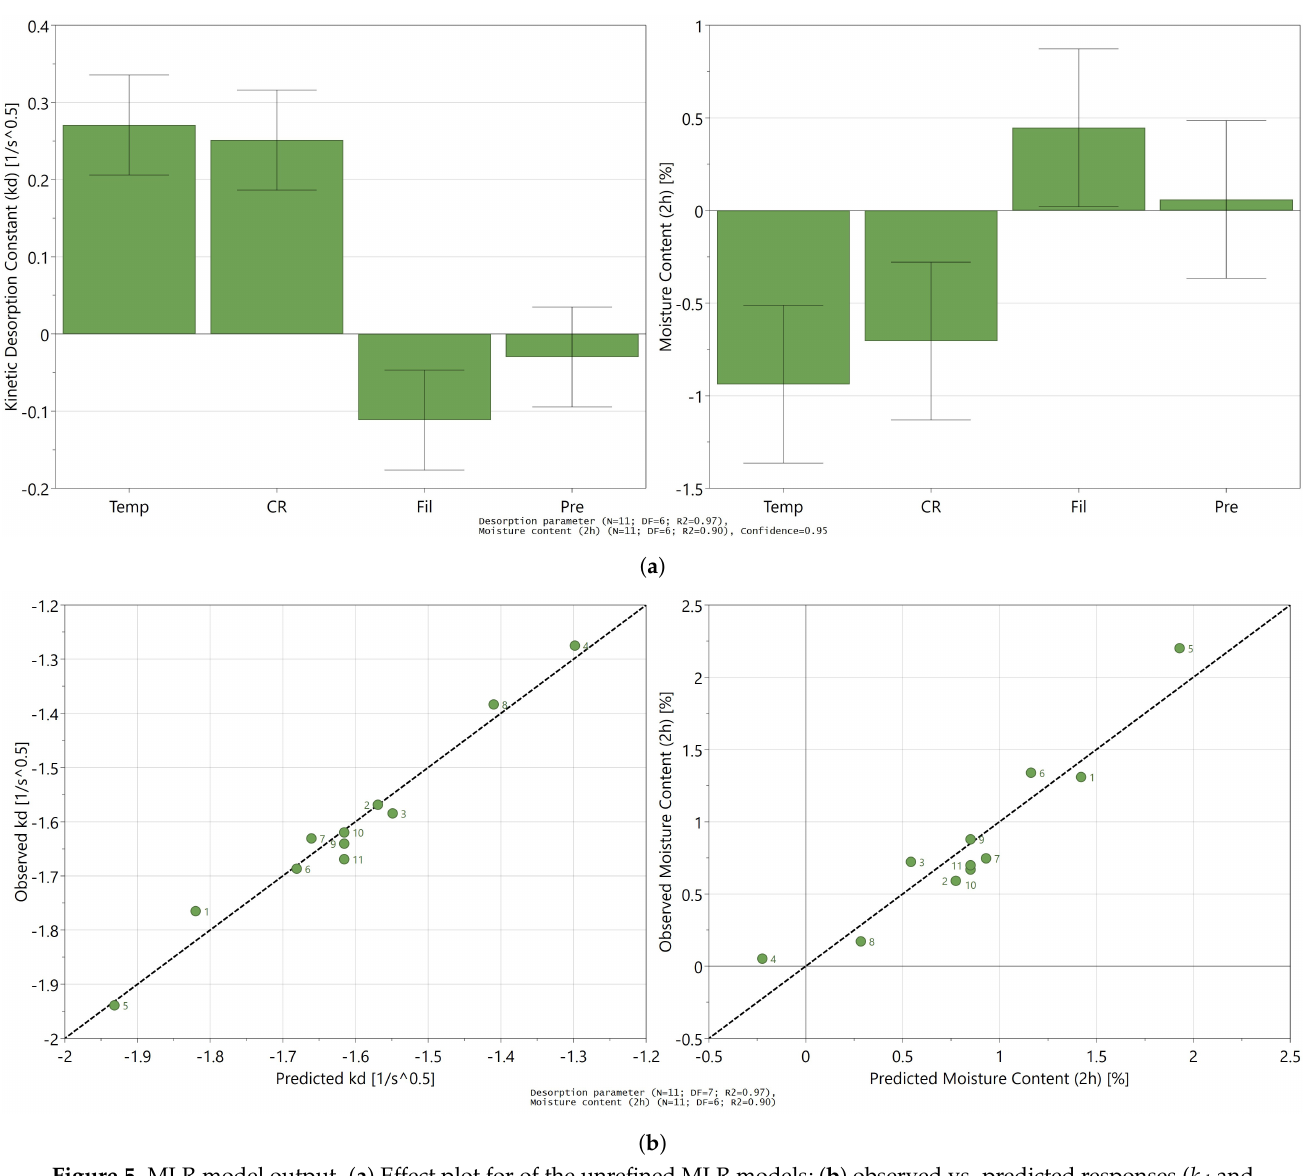
Figure 5. MLR model output. ( a ) Effect plot for of the unrefined MLR models; ( b ) observed vs. predicted responses ( k d and C end ) of the refined MLR models of all performed experimental runs; values of k d were